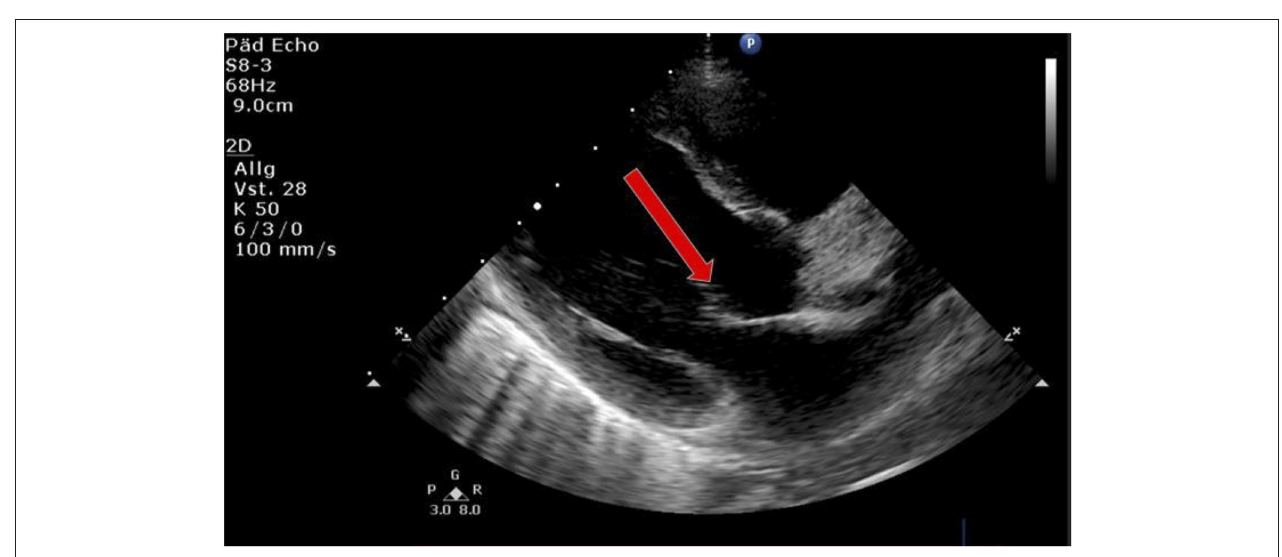
FIGURE 3 | Echocardiography showing prolapse of mitral valve